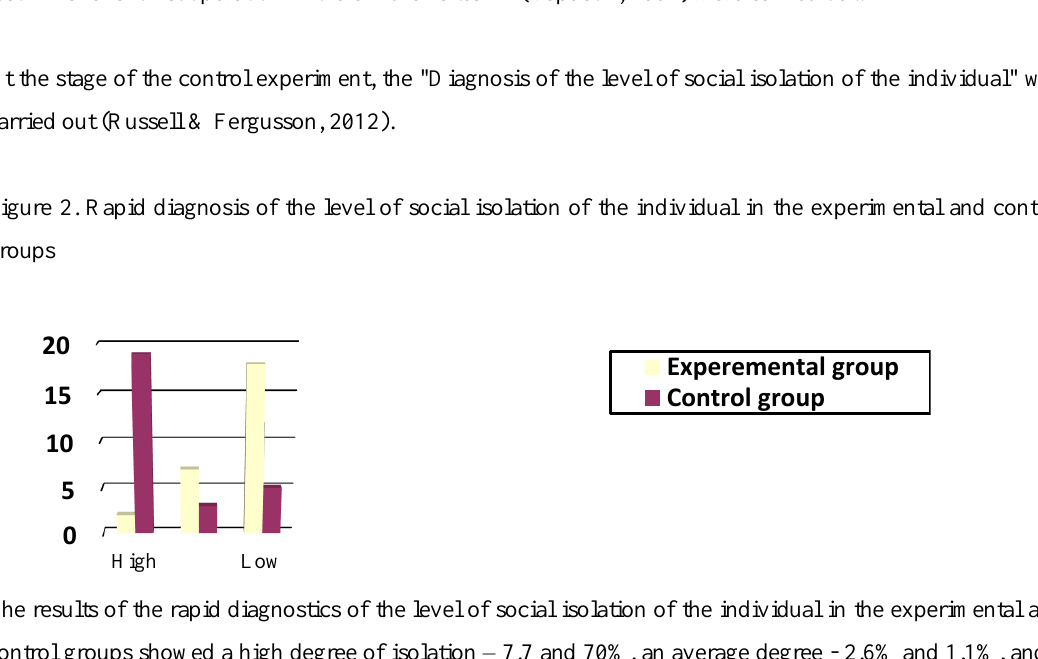
Table 3. The level of education of students (Kapustin, 2001) (experimental and control